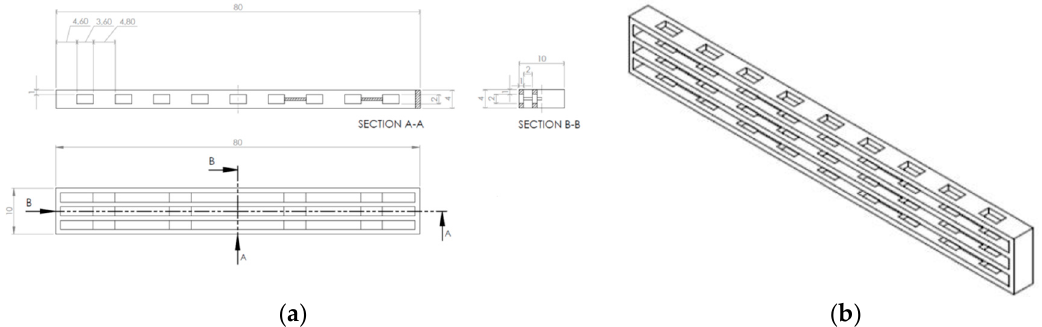
Figure 1. ( a ) Technical drawing and ( b ) 3D representation of the PCL model.